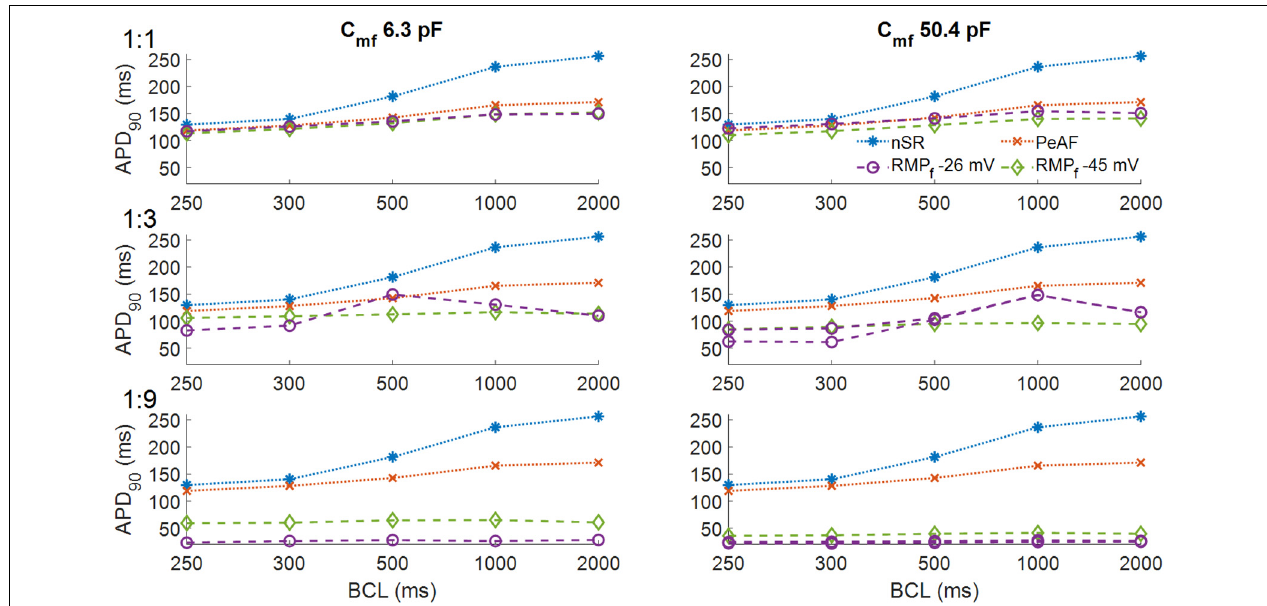
FIGURE 3 | Action potential durations of myocytes in normal sinus rhythm (nSR), under persistent atrial fibrillation electrical remodeling (PeAF) and after being coupled to fibroblasts with a resting membrane potential (RMPf) of –26 or –45 mV in RA (baseline model). In the first column the membrane capacitance of fibroblasts is 6.3 pF and in the second column 50.4 pF. One myocyte was coupled to one fibroblast (1:1) (first row), three fibroblasts (1:3) (second row), and nine fibroblasts (1:9) (third row).